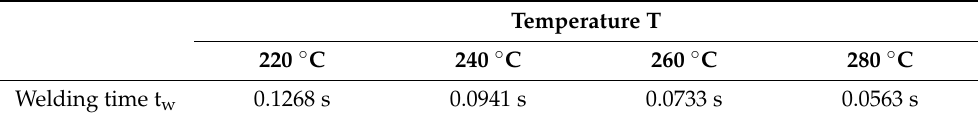
Figure 6. Carreau Fluid Model (CFM) for a melt temperature of 220 °C ( a ) and Arrhenius relation of the temperature dependent welding time t w ( b ). Table 2. Welding time of polypropylene (Moplen HP501H) at different